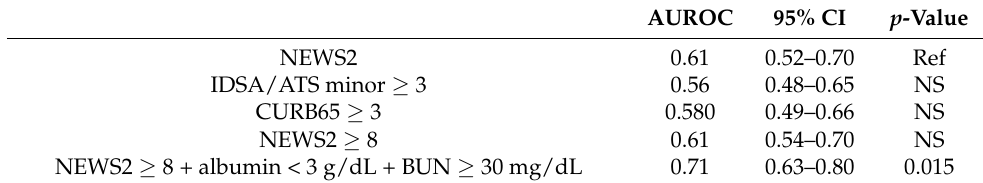
Table 4. AUROC of NEWS2 when compared with IDSA/ATS minor criteria and other prediction tools to predict early progression of